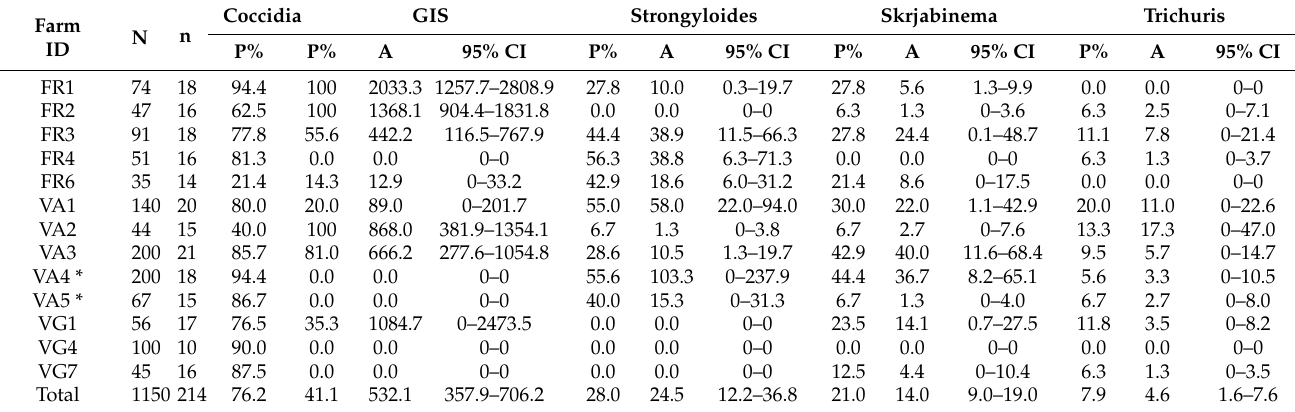
Table 5. Prevalence and mean abundance with 95% confidence interval of gastrointestinal parasites recovered in each farm. Data refer to adult females (n = 214). * In these farms it was not possible to collect as many samples as expected. Farm ID